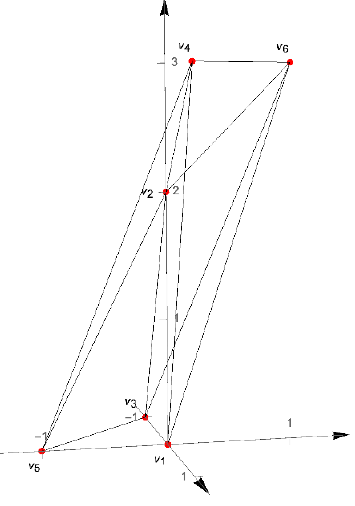
Figure 2 . Toric diagram of Y p;k ( C P 1 (cid:2) C P 1 ) with p = 2, k = 3, obtained by projecting on R 3 the vertices in